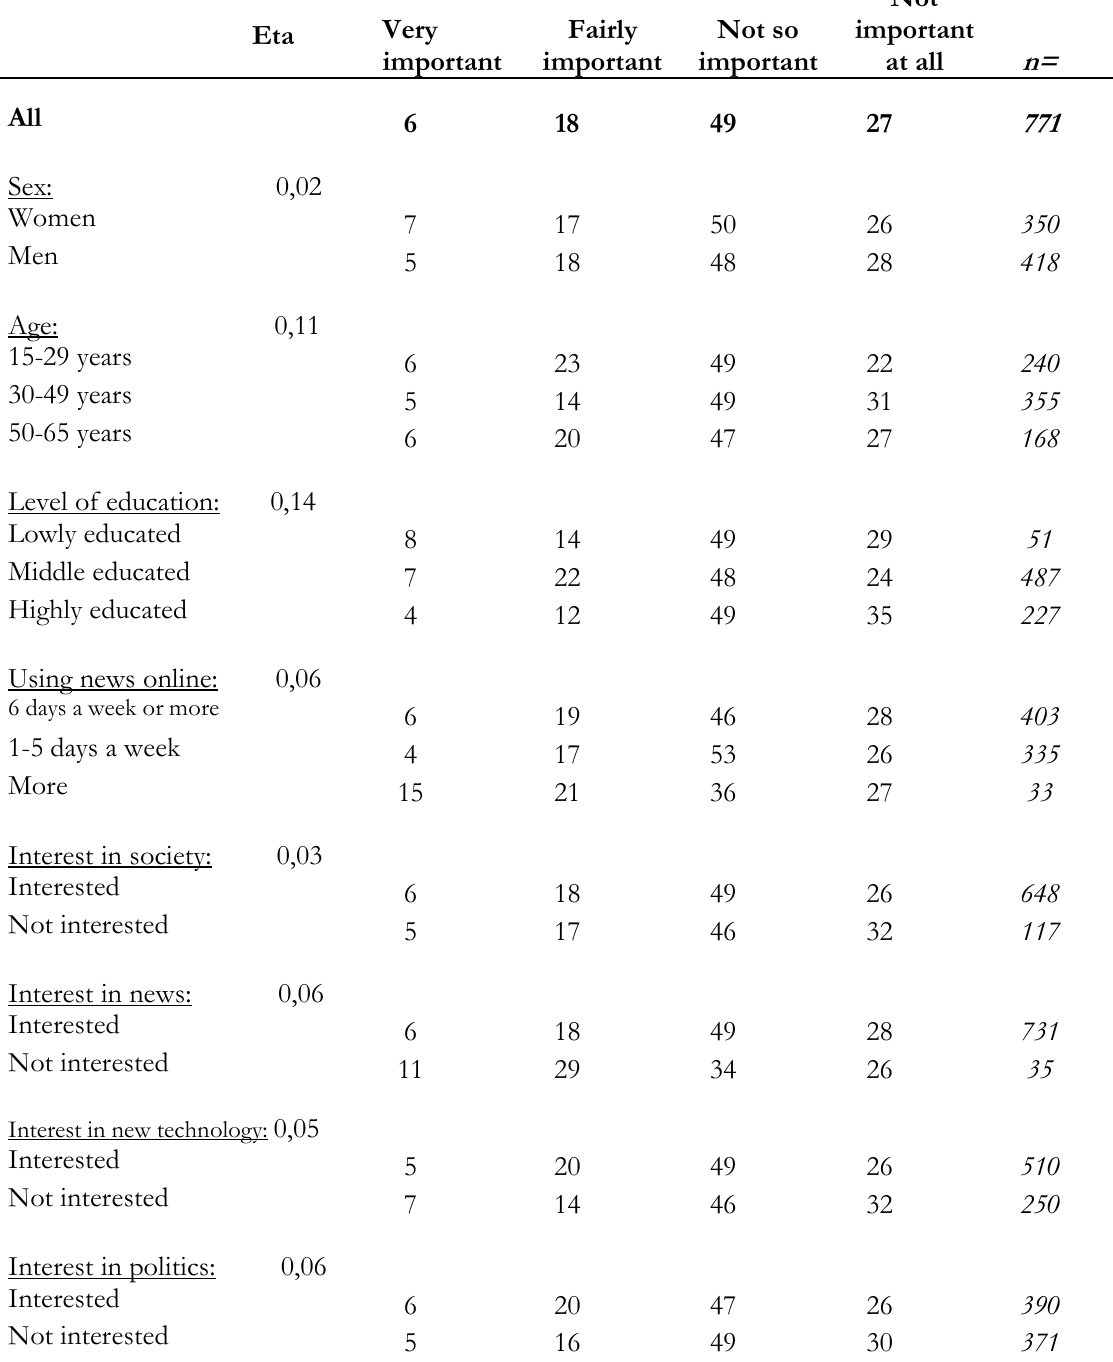
Table 2: Perceived importance of comment facilities on news sites in different groups (eta and per